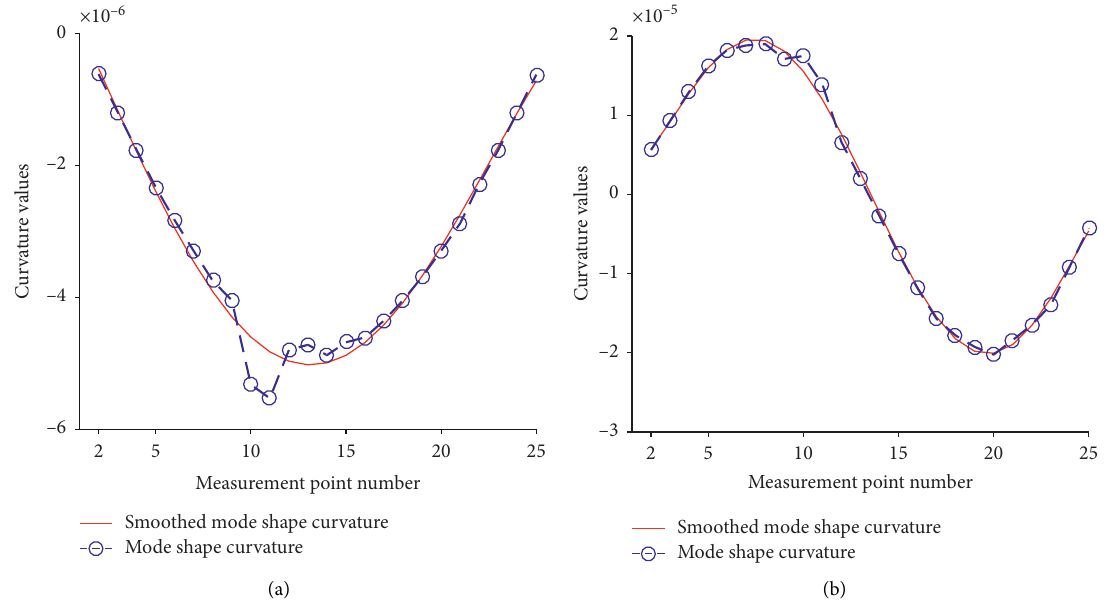
Figure 5: Mode shape curvatures of a simply supported beam with single damage (0.5% for the noise level). (a) First mode. (b) Second